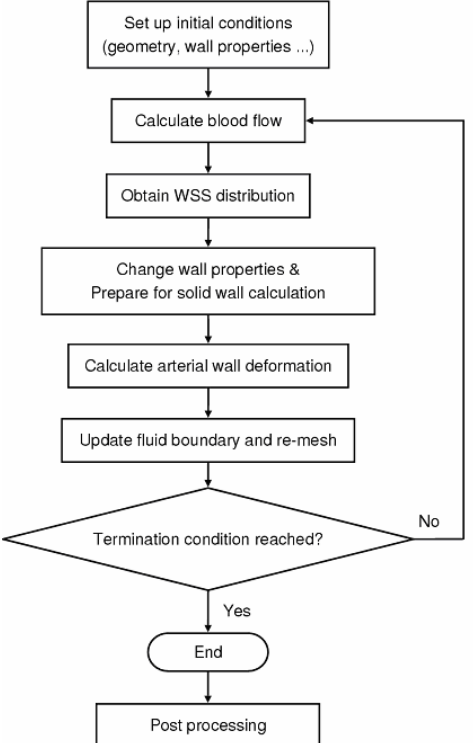
Fig. 1 Flowchart of the simulation of aneurysm genesis and